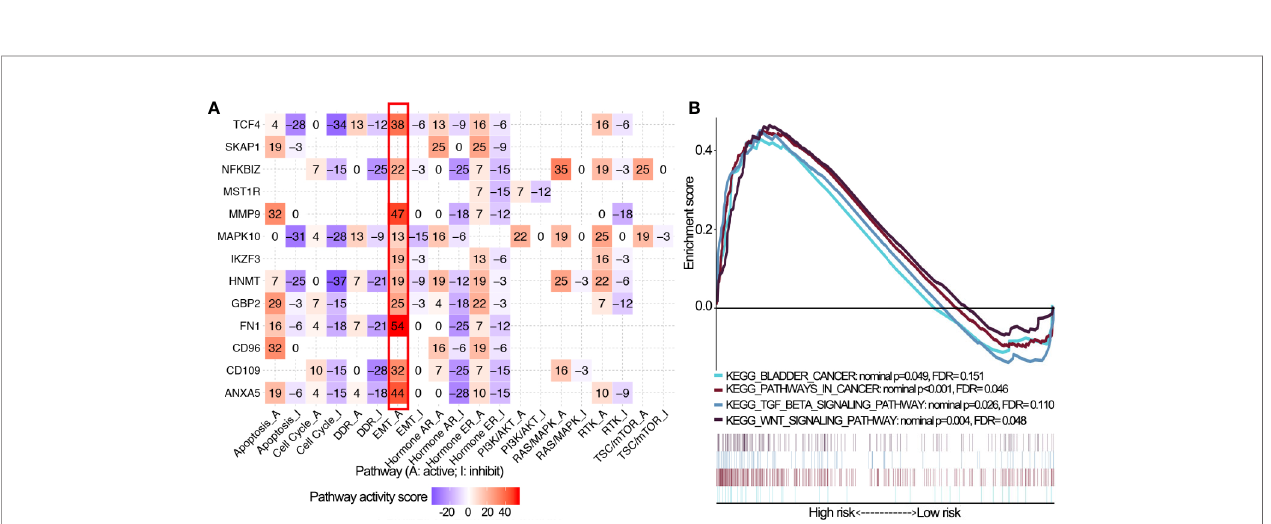
FIGURE 6 | Pathway activity analysis of 14 OS-associated immune genes. (A) The correlation of 14 OS-associated immune genes with 10 cancer related pathways (activation and inhibition). The number represents the pathway activity score. (B) Gene set enrichment analysis for comparing immune phenotype between high and low risk groups. Signi fi cant enrichment of four cancer-related KEGG terms in high risk group. OS, overall survival; KEGG, Kyoto Encyclopedia of Genes and Genomes; FDR, false discovery